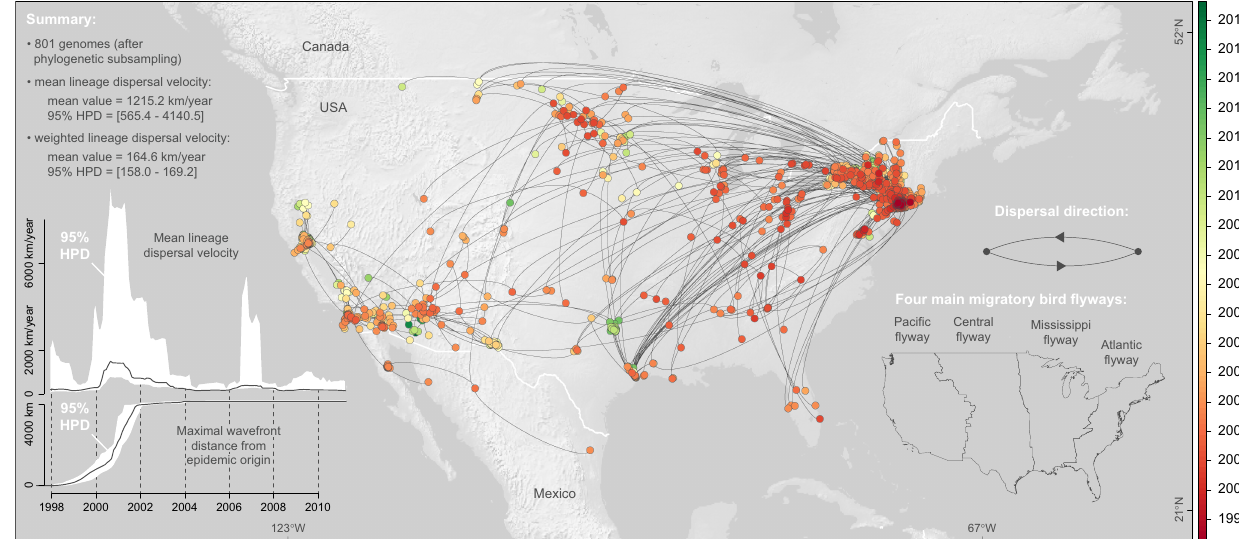
Fig. 1 Spatio-temporal diffusion of WNV lineages in North America. Maximum clade credibility (MCC) tree obtained by continuous phylogeographic inference based on 100 posterior trees (see the text for further details). Nodes of the tree are coloured from red (the time to the most recent common ancestor, TMRCA) to green (most recent sampling time). Older nodes are plotted on top of younger nodes, but we provide also an alternative year-by-year representation in Supplementary Fig. S1. In addition, this fi gure reports global dispersal statistics (mean lineage dispersal velocity and mean diffusion coef fi cient) averaged over the entire virus spread, the evolution of the mean lineage dispersal velocity through time, the evolution of the maximal wavefront distance from the origin of the epidemic, as well as the delimitations of the North American Migratory Flyways (NAMF) considered in the USA.